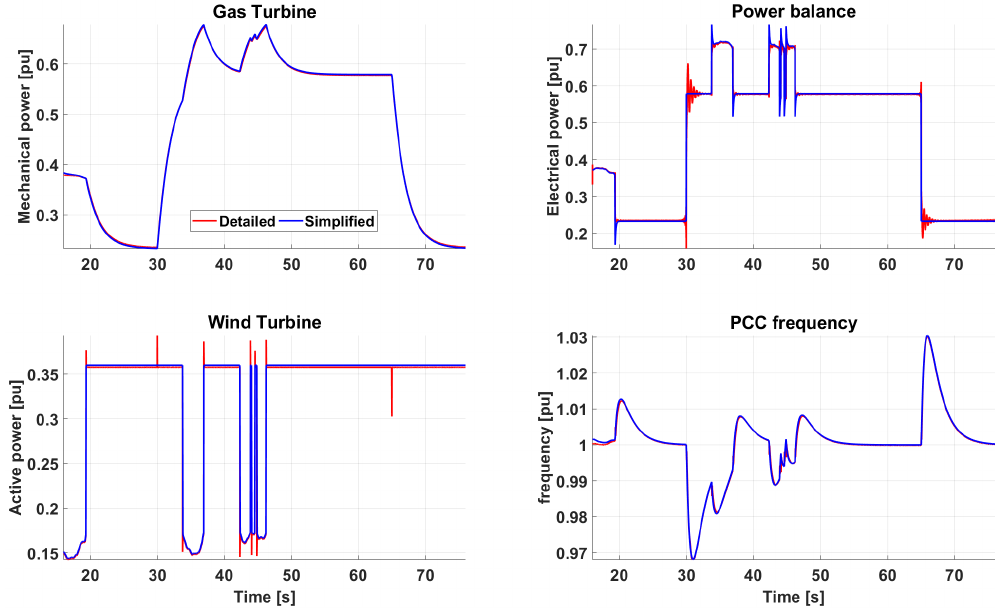
Figure 8. Detailed versus simplified model without ESS.